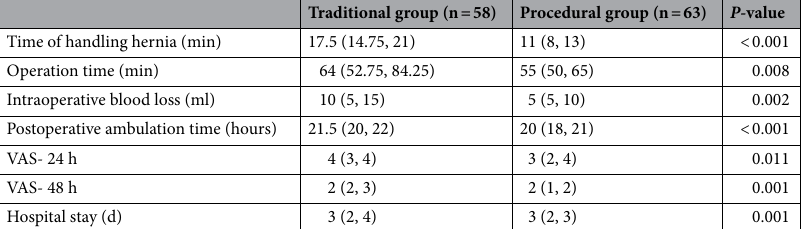
Table 2. Comparison of surgical conditions between the traditional group and the procedural group [median (25% quartile, 75% quartile)]. VAS visual analog scale.